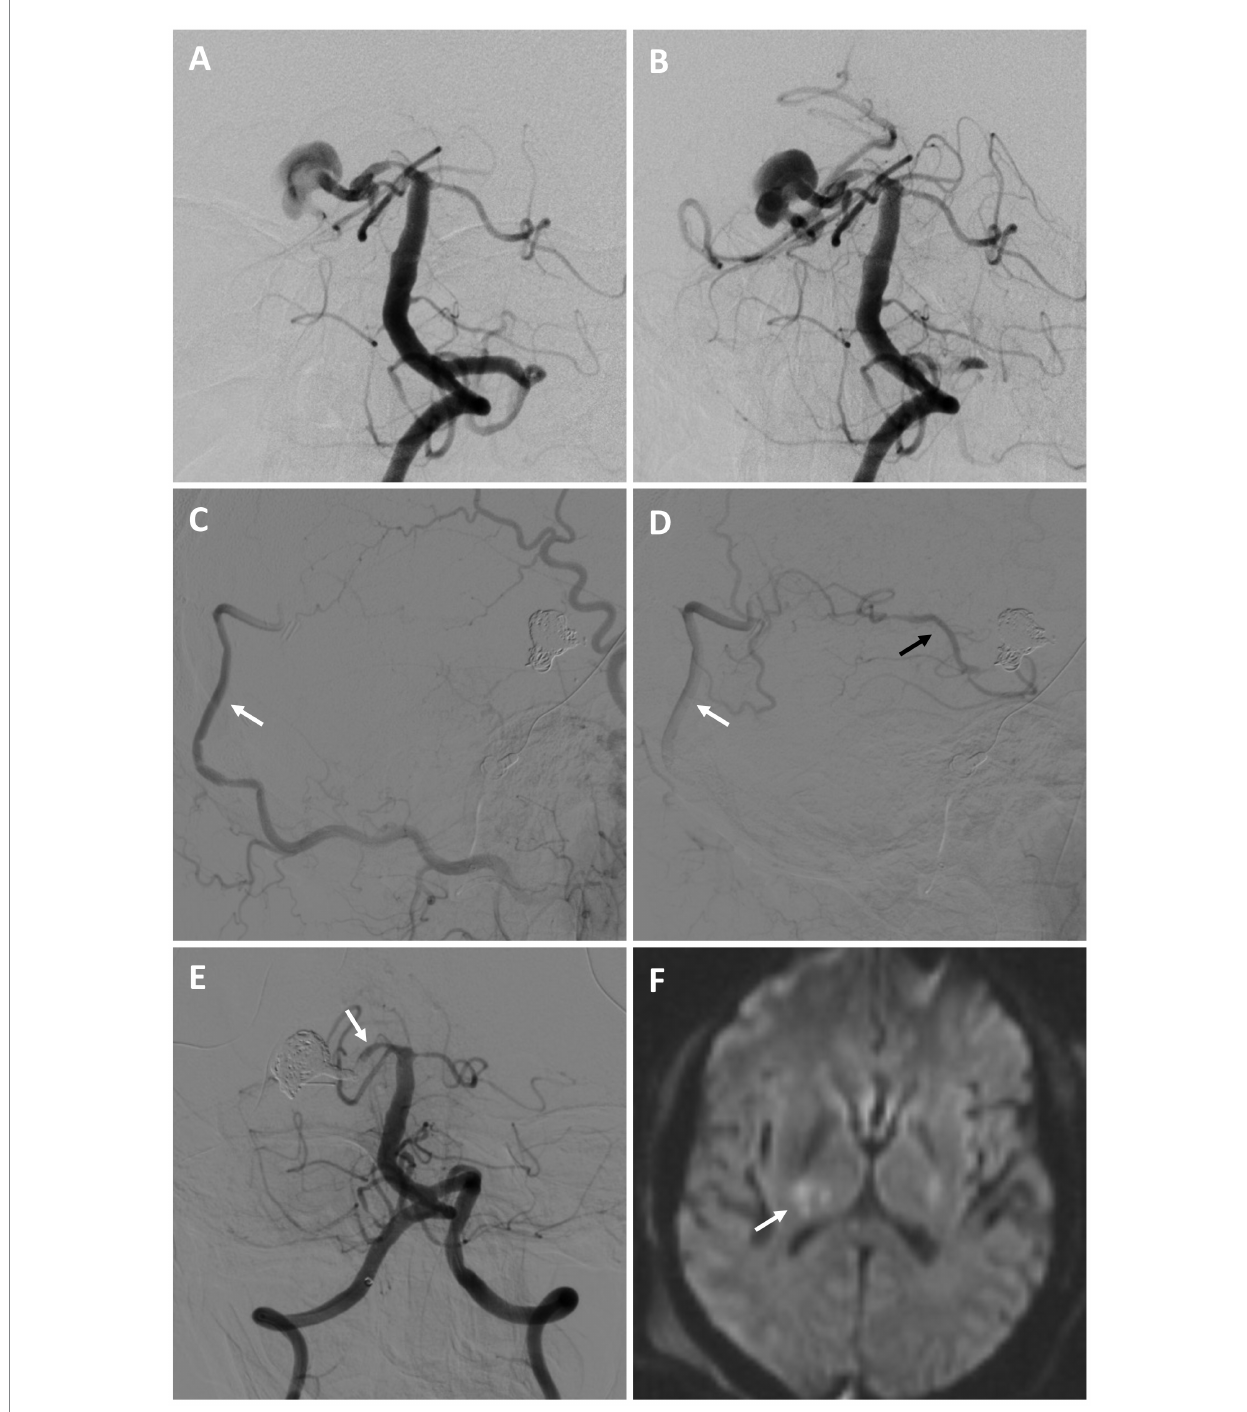
FIGURE 4 Patient #10. A 53-year-old male was referred for a large right fusiform P2 aneurysm with a proximal dysplastic P1 vessel [ (A,B) AP angiogram of the left vertebral artery]. A prior attempt at flow diversion was aborted due to unfavorable anatomy. He underwent a right OA to P4 bypass with a DLCFA interposition graft, followed by a coil embolization/vessel sacrifice of the right P2 aneurysm (keeping the proximal right P1 patent) after BTO [ (C,D) serial lateral images from a right external carotid artery injection demonstrating patency of the bypass (white arrows) and backfilling of the PCA territory (black arrow)]. The right P1 was kept open to preserve perforator flow [ (E) AP angiogram of the right vertebral artery (arrow highlights right P1)]. Post- operatively he experienced a small right thalamic stroke [ (F) axial diffusion-weighted MRI, arrow highlighting stroke], likely from perforators off the severely diseased and sacrificed P2 segment, as well as a small right occipital stroke of unclear etiology (not shown). He had left mild hemiparesis and a partial left hemianopsia. This significantly improved on 9-month follow, where he was living at home and performing all activities of daily living